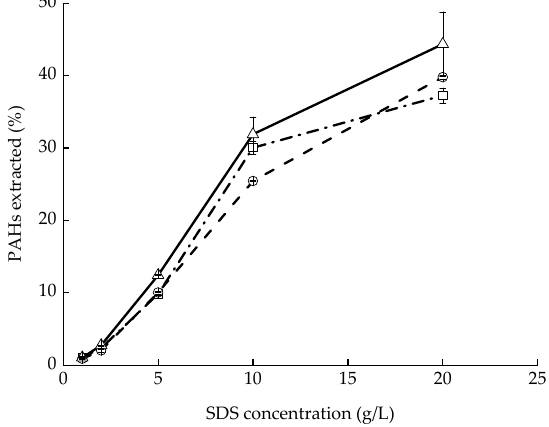
Figure 2. The washing efficiencies of (-·- □ -·-) phenanthrene (PHE), (- - ○ - -) fluoranthene (FLU), and (— △ —) pyrene (PYR) at different concentrations of sodium dodecyl sulfate (SDS). Values are presented as means and standard deviation.